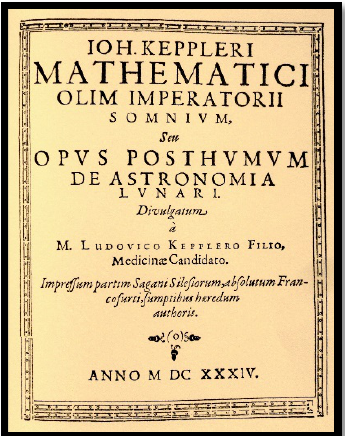
Fig. 1 . Front page of Kepler’s science fiction book Somnium. Source: